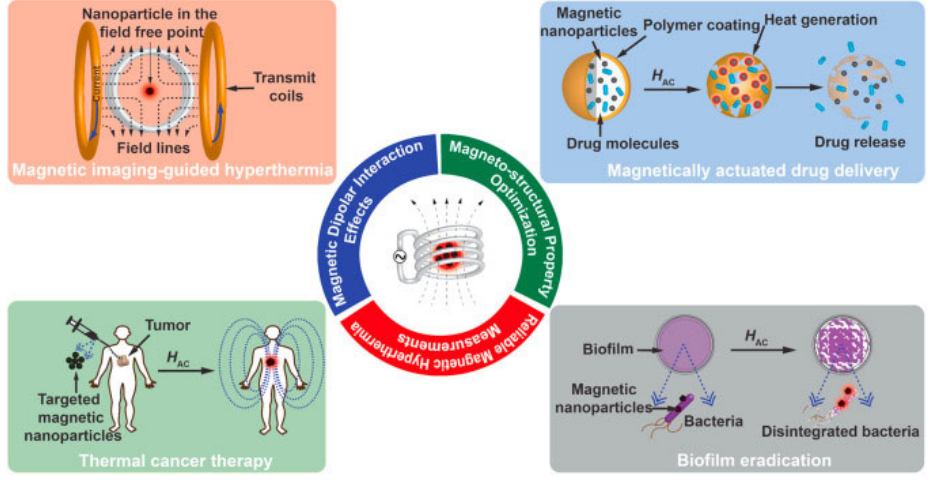
Figure 9. Schematic illustration of magnetic nanoparticle-mediated hyperthermia for cancer therapy. Reprinted from Ref. [225]. Copyright 2016 Elsevier.